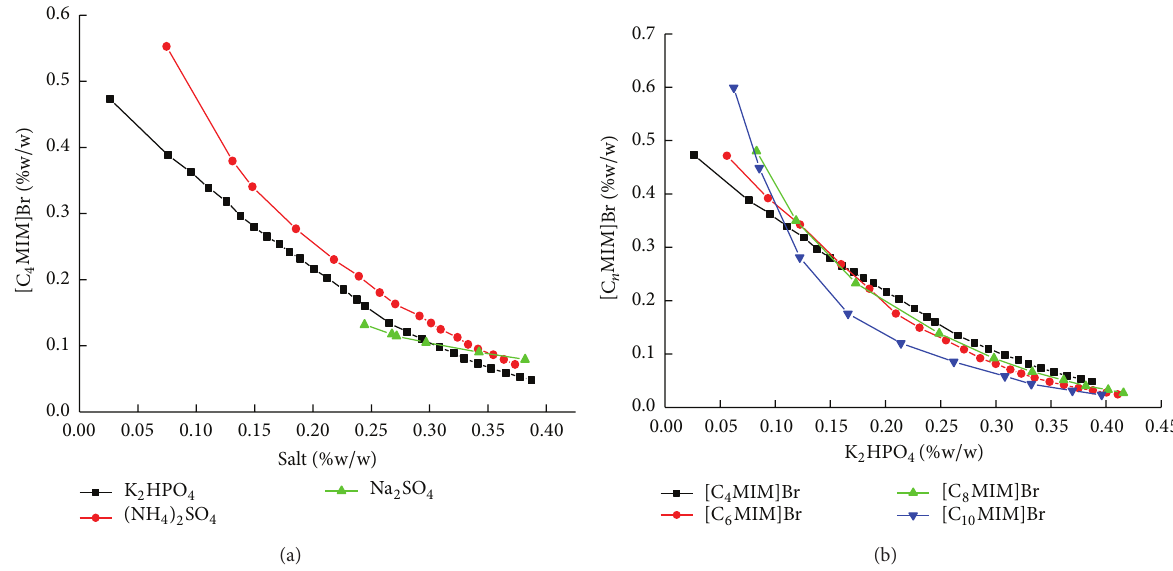
Figure 1: Phase diagrams of different salts (a) and [ C 𝑛 MIM ] Br (b) for the ILs/salt/water systems at 25 ∘